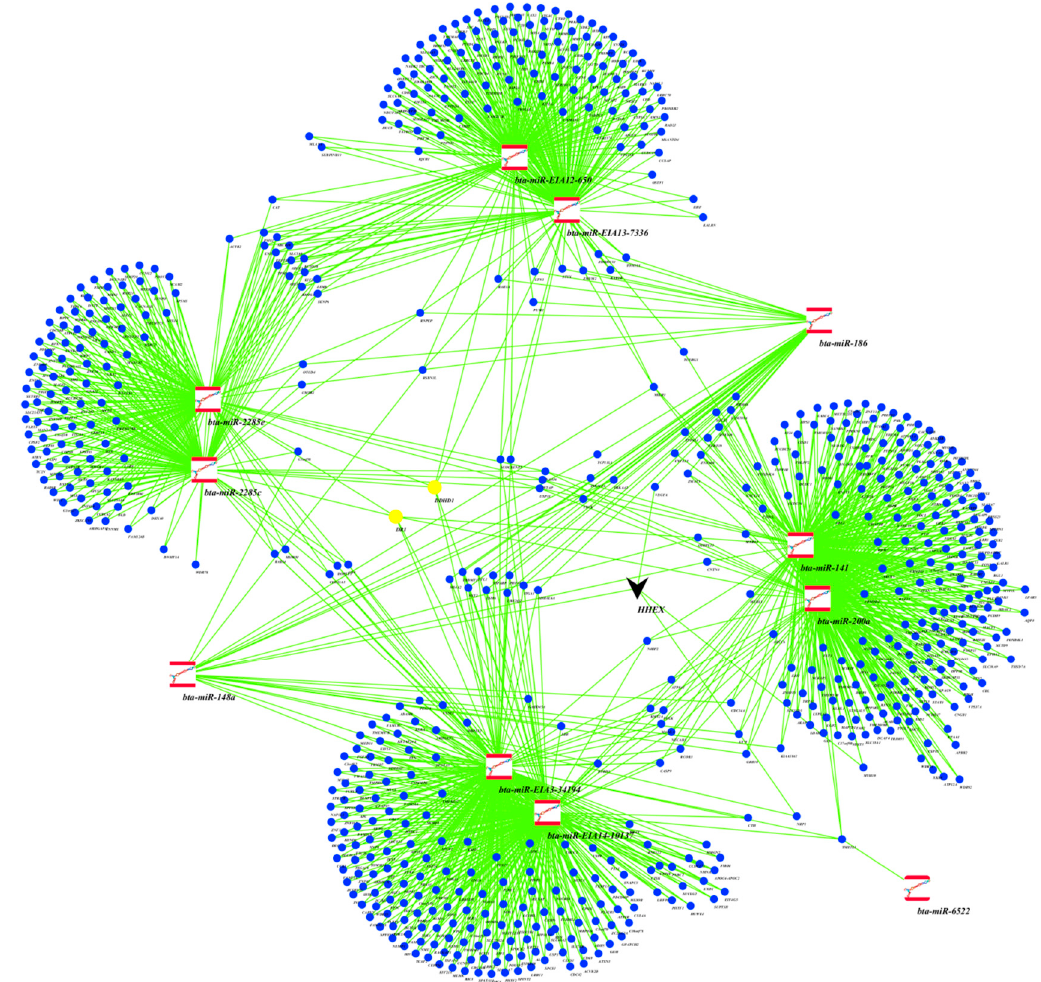
Figure 2. Predicted target genes of miRNAs in the GREEN module, and important hub genes and transcription factors. The red square nodes are miRNA members of the GREEN module, the blue round nodes are common predicted target genes for these miRNAs, the yellow round nodes are most highly predicted common (hub) target genes for these miRNAs, and the black V shape is the transcription regulator targeted by miRNAs, which also targets other predicted target genes in the networks.